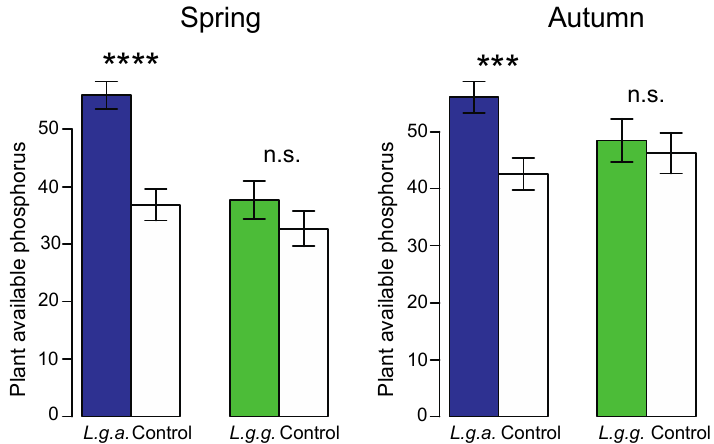
Figure 8. Plant-available phosphorus in Lamium galeobdolon subsp. argentatum plots, Lamium galeobdolon subsp. galeobdolon plots and corresponding control plots in both spring and autumn. Mean values ± s.e. are shown, n = 18. Differences were tested using paired t -tests; *** p < 0.001, **** p < 0.0001, n.s. not significant).